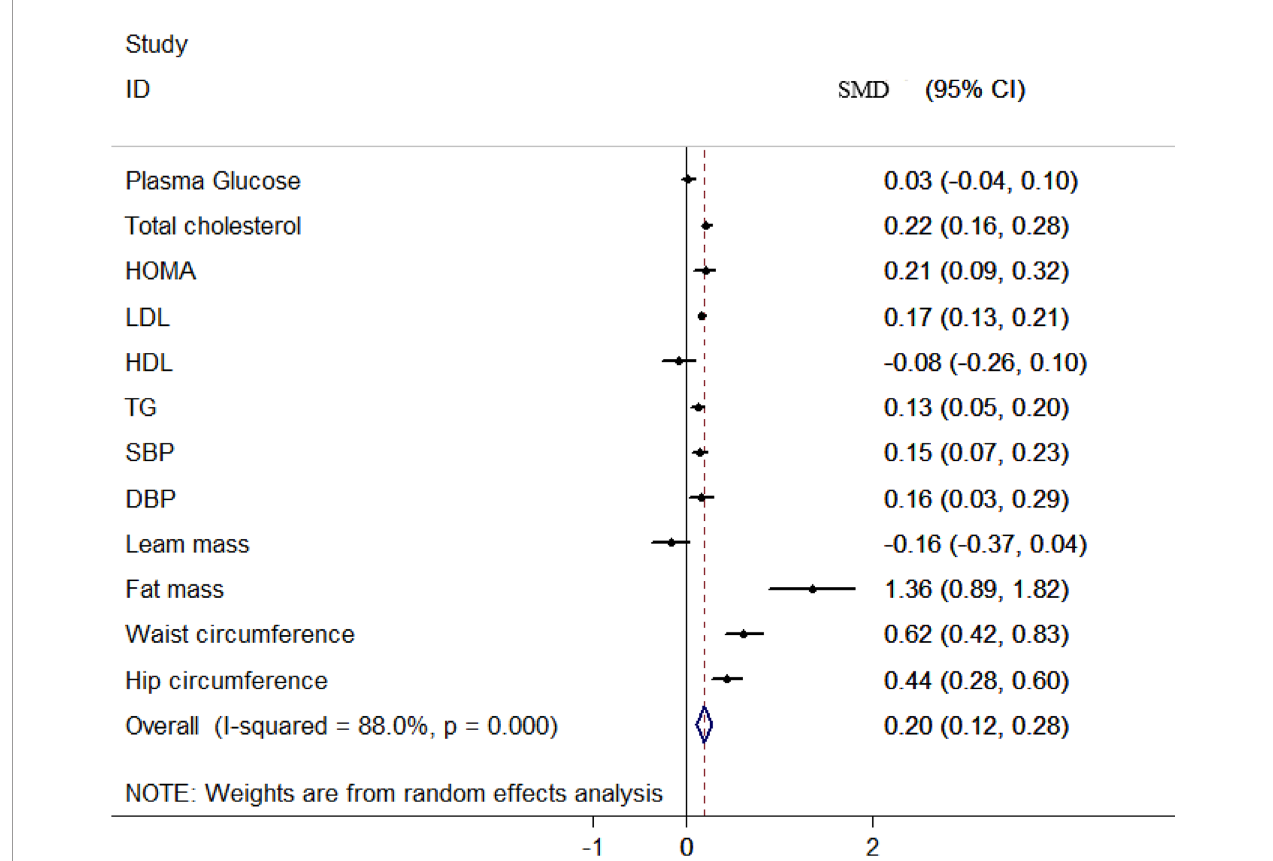
FIGURE 3 | Forest plot detailing the pooled association between NWO with mean